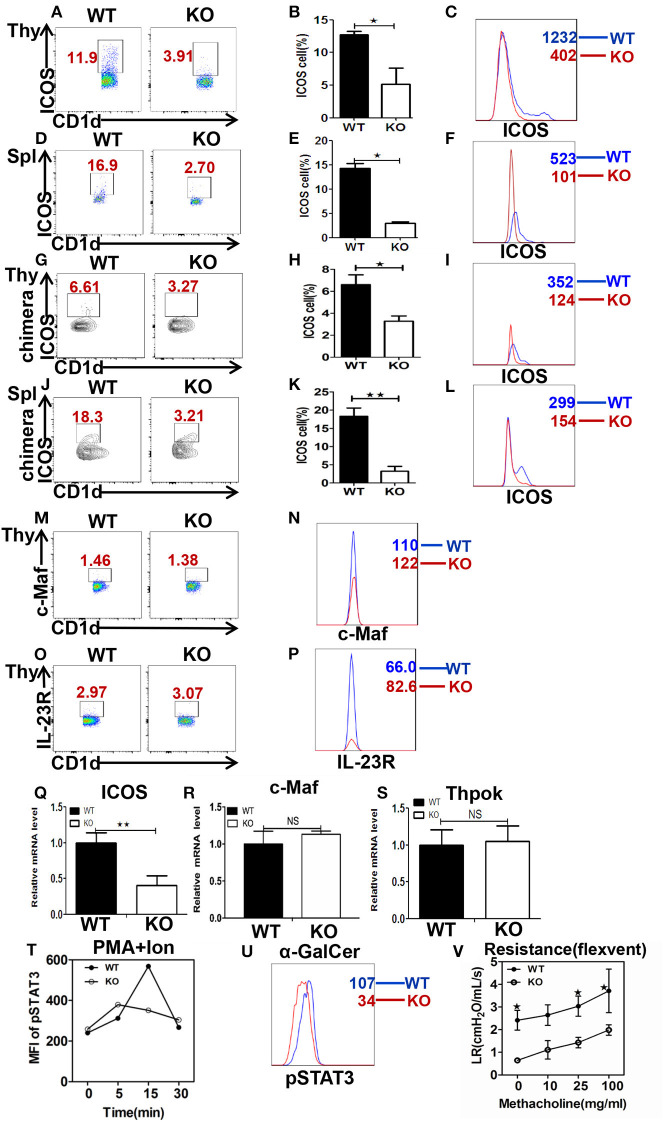
Akt2 regulates the NKT17 differentiation by promoting the expression of ICOS. (A–F) The percentages of ICOS of WT and Akt2 KO cells in thymus (n = 3 mice per group) and spleen (n = 3 mice per group) is shown. (C,F) Overlaid histograms show expression of ICOS in the thymus and spleen. (G–L) The percentages of ICOS of CD45.2+ cells in thymus and spleen of WT chimera mice (n = 4) and Akt2 KO chimera mice (n = 3) is shown. (I,L) Overlaid histograms show expression of ICOS in the thymus and spleen of chimeras. (M,N) The Flow cytometry of c-Maf and expression of c-Maf in the thymus. (O,P) Flow cytometry of IL-23R and expression of IL-23R in the thymus. (Q–S) mRNA levels of indicated molecules in WT and Akt2 KO iNKT cells. Expression of indicated mRNA from MACS- and FACS- sorted WT and Akt2 KO iNKT cells from freshly isolated thymocytes was quantified by real-time qPCR from three independent experiments. *p < 0.05; **p < 0.01, Student's t-test. (T) Flow cytometry analysis of the pSTAT3 for MFI in thymocytes from WT (n = 3) and Akt2 KO mice (n = 3). (U) Overlaid histograms show expression of pSTAT3 after α-GalCer stimulated 72 h. (V) Airway response to methacholine of WT (n = 3) and Akt2 KO mice (n = 3). LR, lung resistance from two independent experiments. *p < 0.05, Student's t-test.